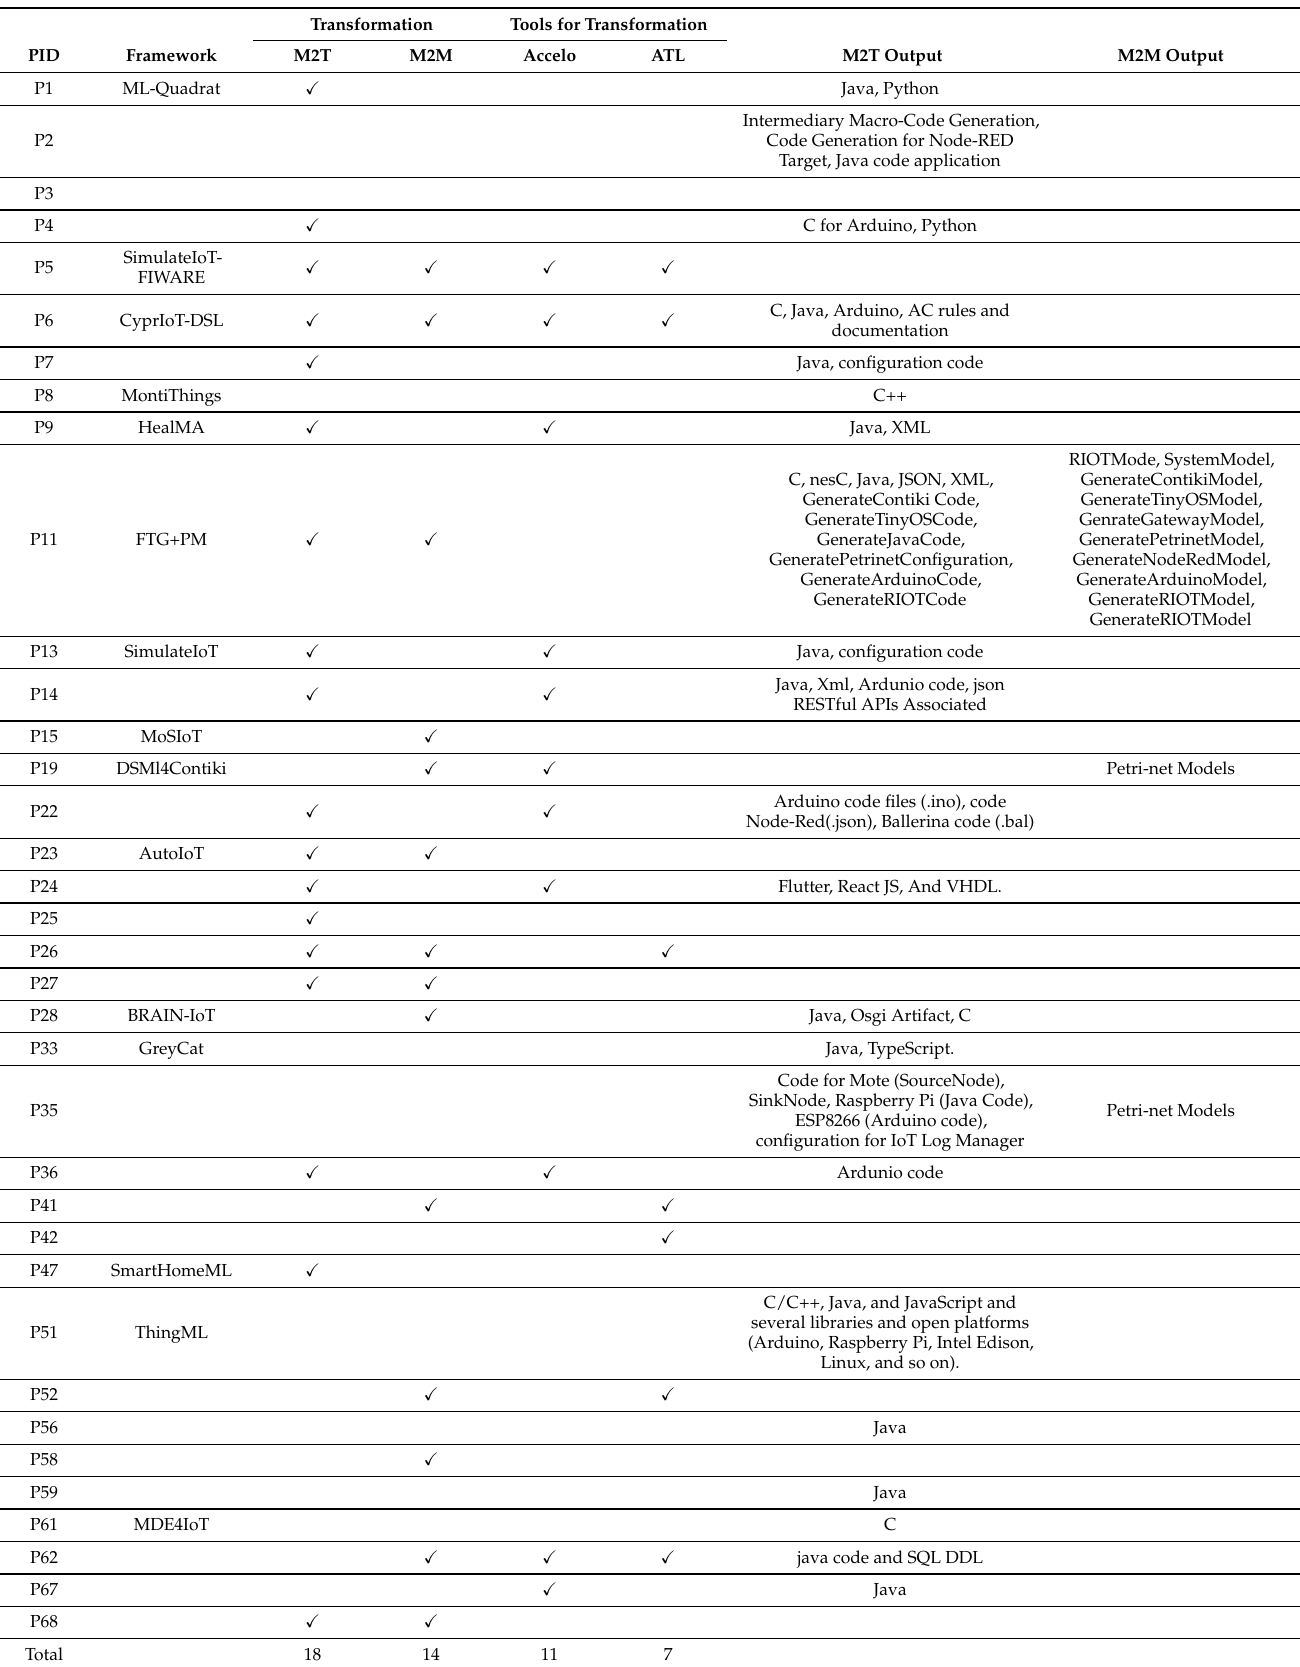
Table 4. Distribution of papers by types of model-based transformations and tools. Tools for